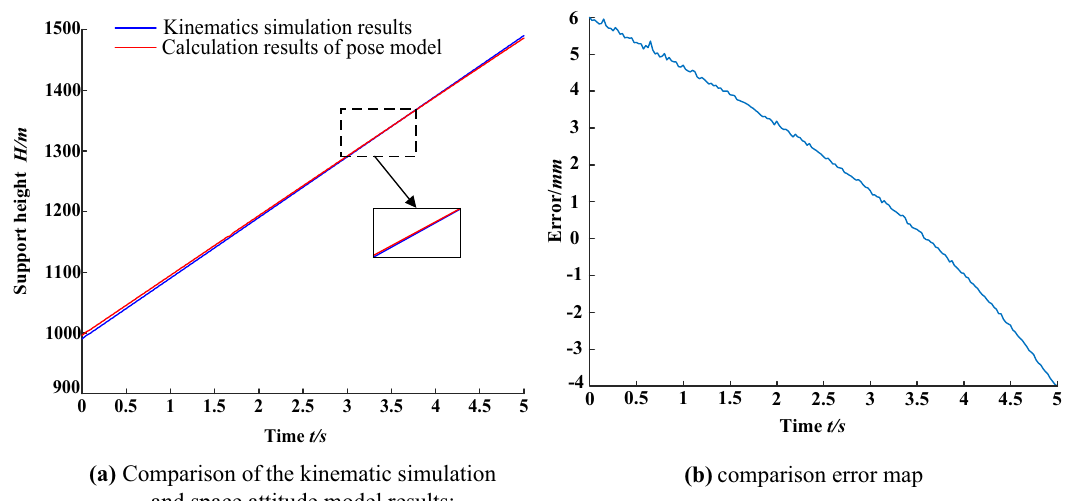
Figure 12. Comparison of the simulation results of the kinematic support height of the advance hydraulic support. Balance cylinder stretching length L